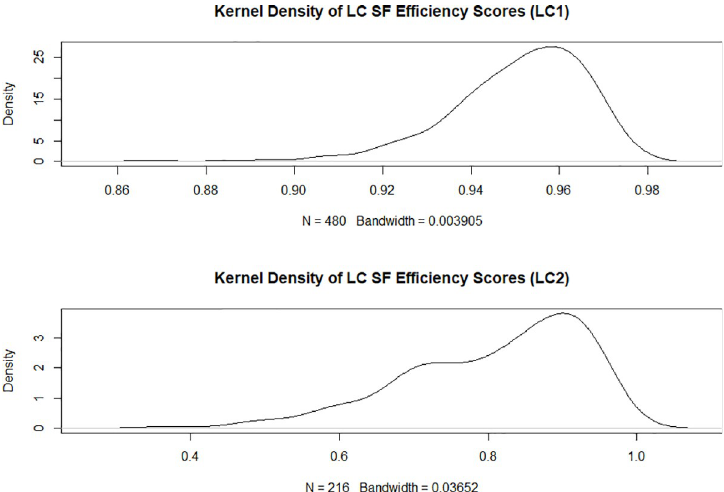
Fig 3. Kernel density estimate for the latent class stochastic frontier efficiency scores for the latent classes (latent class one above). Source: own illustration.